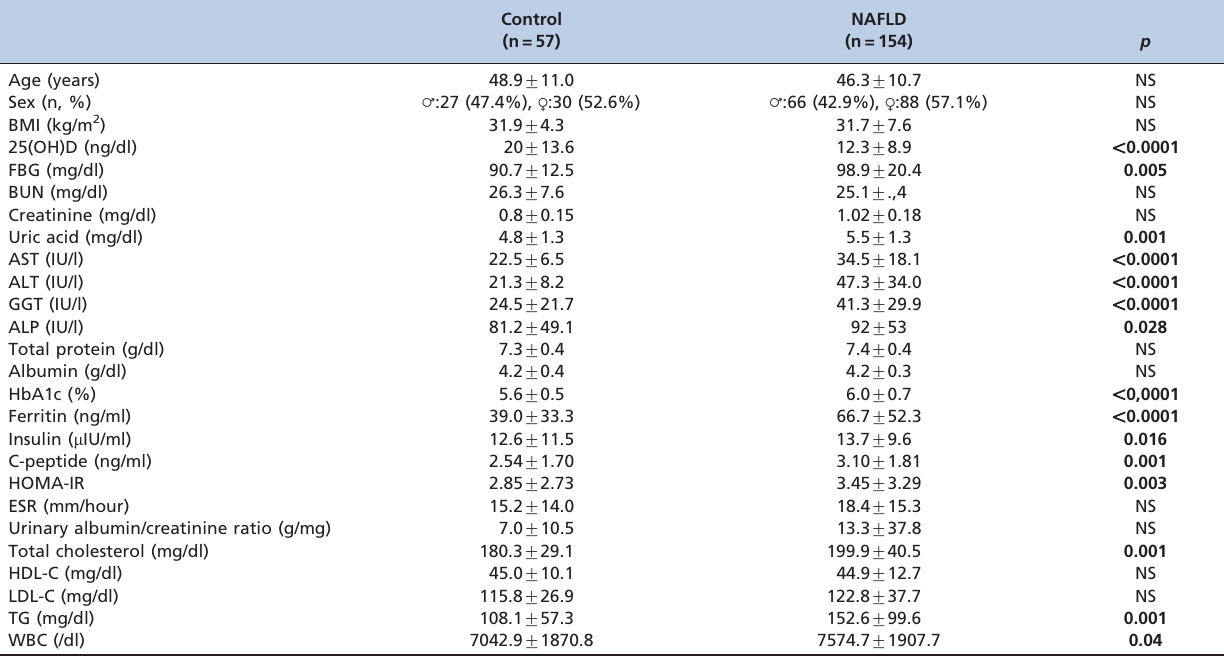
Table 1 - General characteristics and laboratory measurements among the